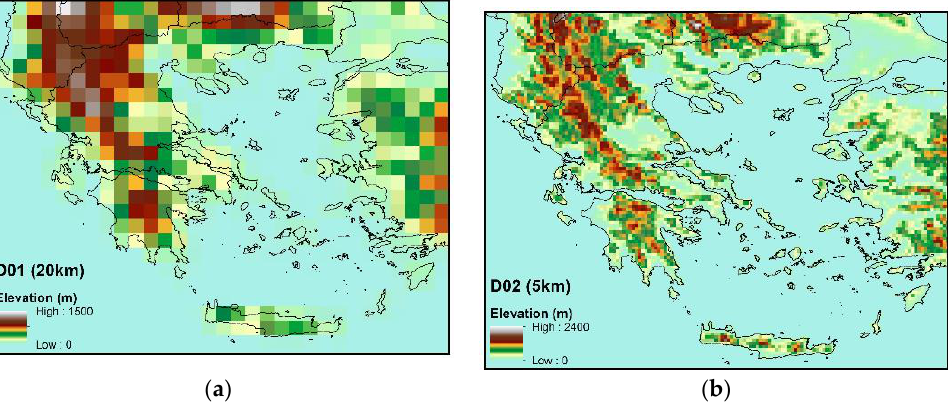
Figure 4. The model’s topography according to the horizontal resolution of (a) the outermost and (b) the inner domains for the area of Greece.